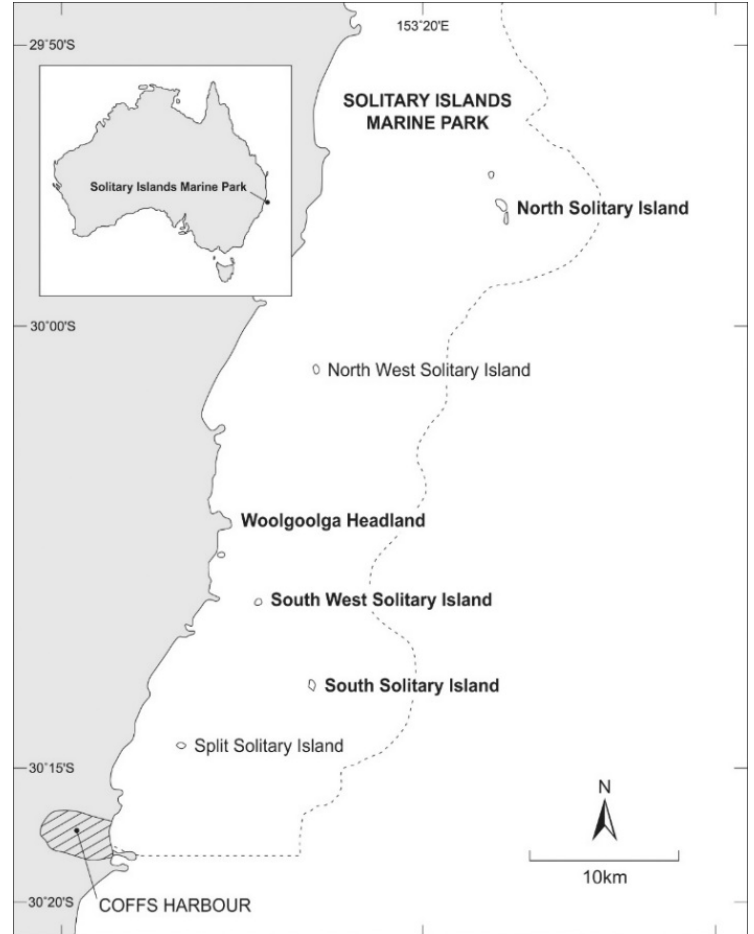
Figure 1. The Solitary Islands Marine Park (boundary shown as a dotted line), subtropical eastern Australia. The geographical scope of the Coffs Coast Sea Slug Census included the entire marine park. Locations of observations for the seven species covered in this paper appear in bold font.